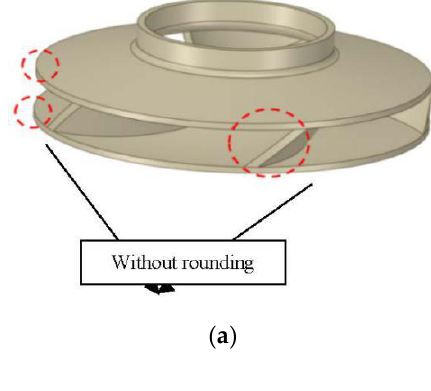
( b ) Figure 5. Model comparison before and after impeller rounding. ( a ) Original impeller; ( b ) rounded impeller and roundness details of the impeller ( t = blade thickness, R = radius of blade rounding). 3.2.2. Flow Region and Grid Generation In FLUENT 18.2, the flow region of the PAT required for the simulation is extracted. As shown in Figure 6, the fluid was split into five component parts; these were volute, impeller, casing, inlet pipe, and outlet pipe. This separation allowed each mesh to be gen- erated individually and tailored to the flow requirements in that particular component, as shown in Figure 7. To get a relatively stable inlet and outlet flow, four times the pipe diameter had been extended in the PAT inlet and outlet section. The number of grids is about 2.15 million. Figure 6. Flow region, with ( 1 ) impeller; ( 2 ) volute; ( 3 ) case; ( 4 ) inlet pipe; and ( 5 ) outlet pipe.